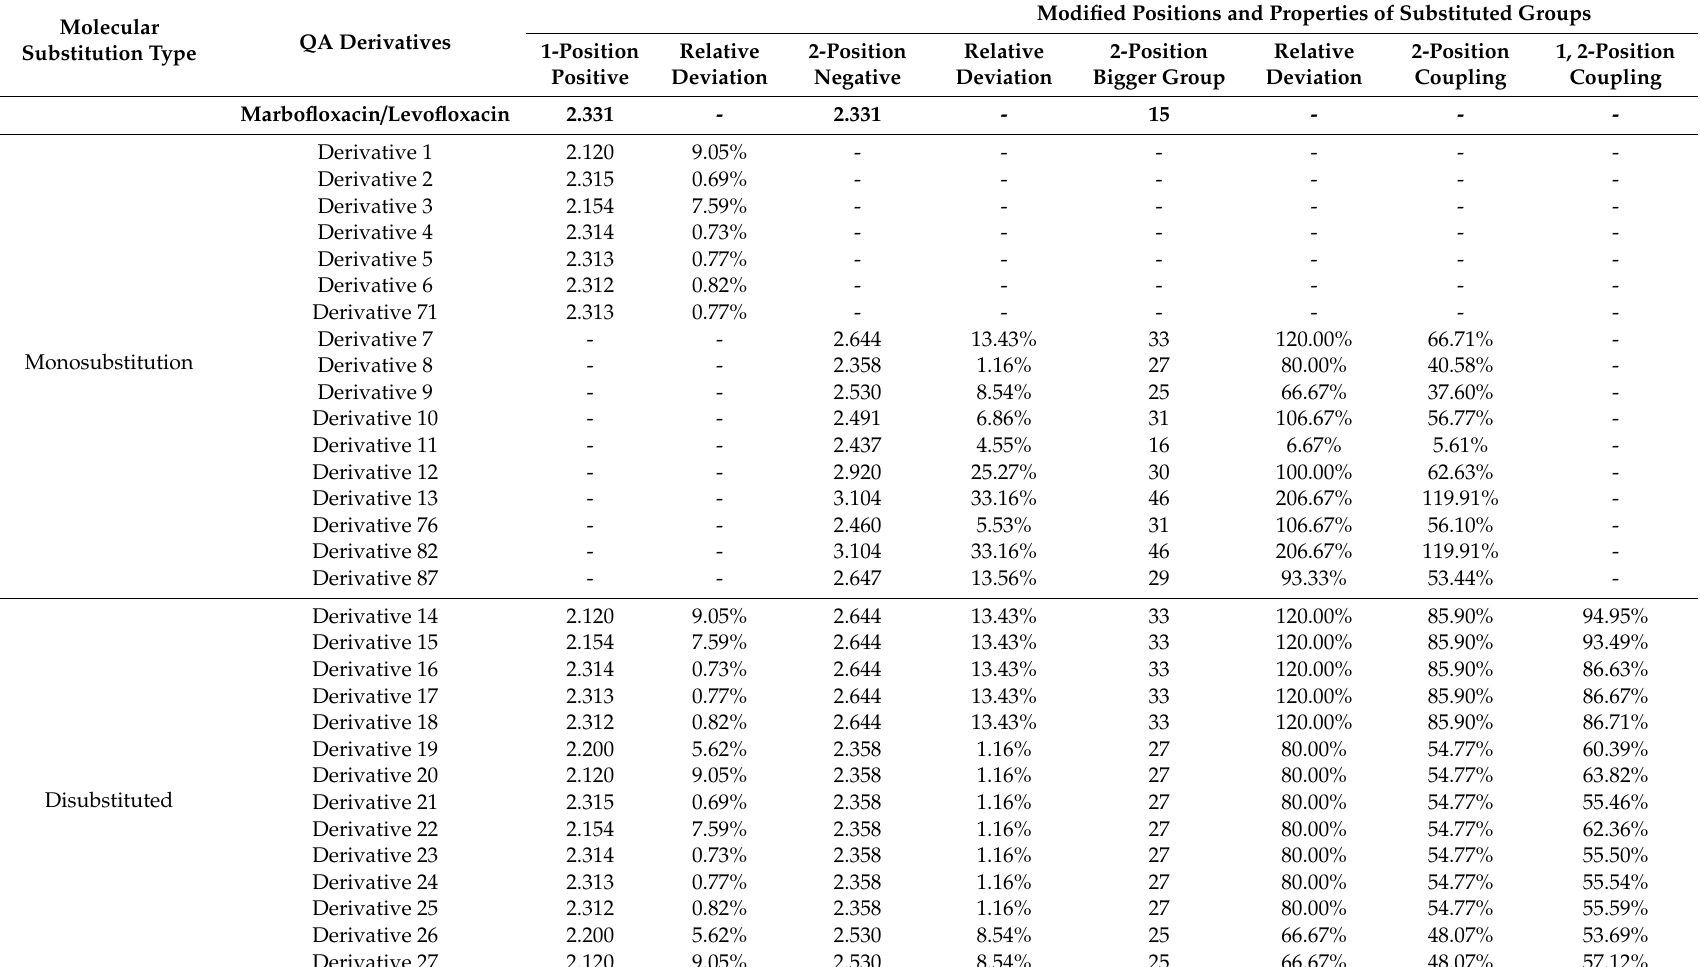
Table 7. The modified positions and properties of 87 QAs